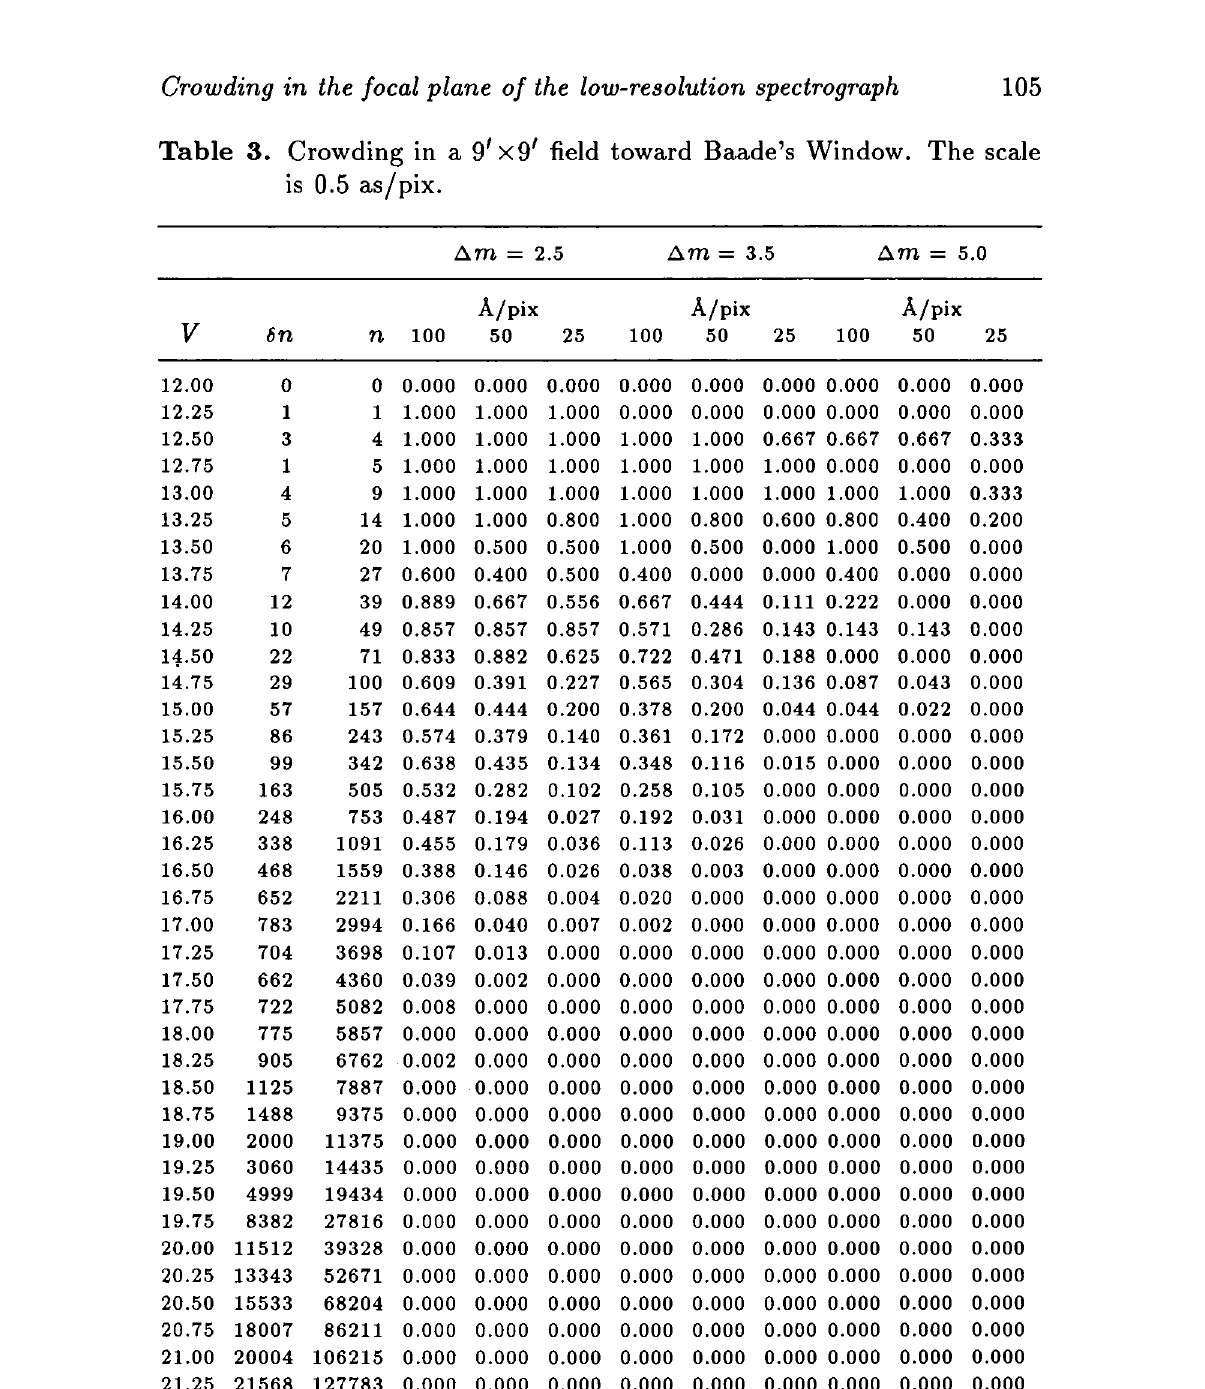
Table 3. Crowding in a 9'x9' field toward Baade's Window. The scale is 0.5